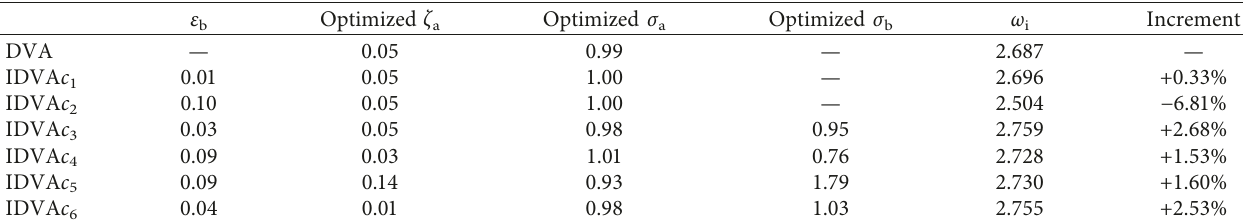
Figure 9: The response of the rotor/seal system at s � 3. (a) The frequency spectrum of the x coordinate. (b) The orbit of the rotor. (c) The Poincar´e map of the x coordinate. Table 2: The comparison results of the instability threshold speed.